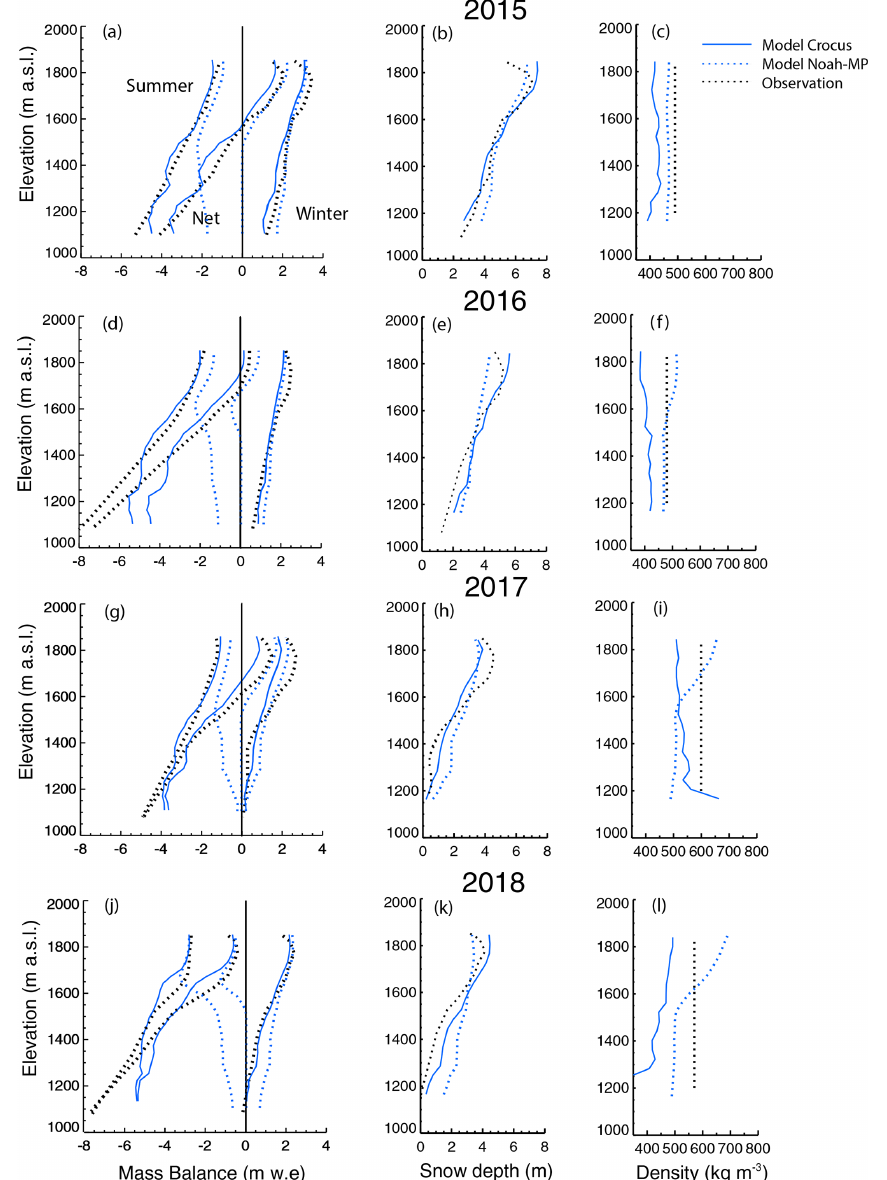
Figure 8. (a, d, g, j) Mass balance across Rembesdalskåka with height. (b, e, h, k) Accumulated snow thickness associated with the winter mass balance. (c, f, i, l) Snow density of the accumulated snow. Each row represents a different year.